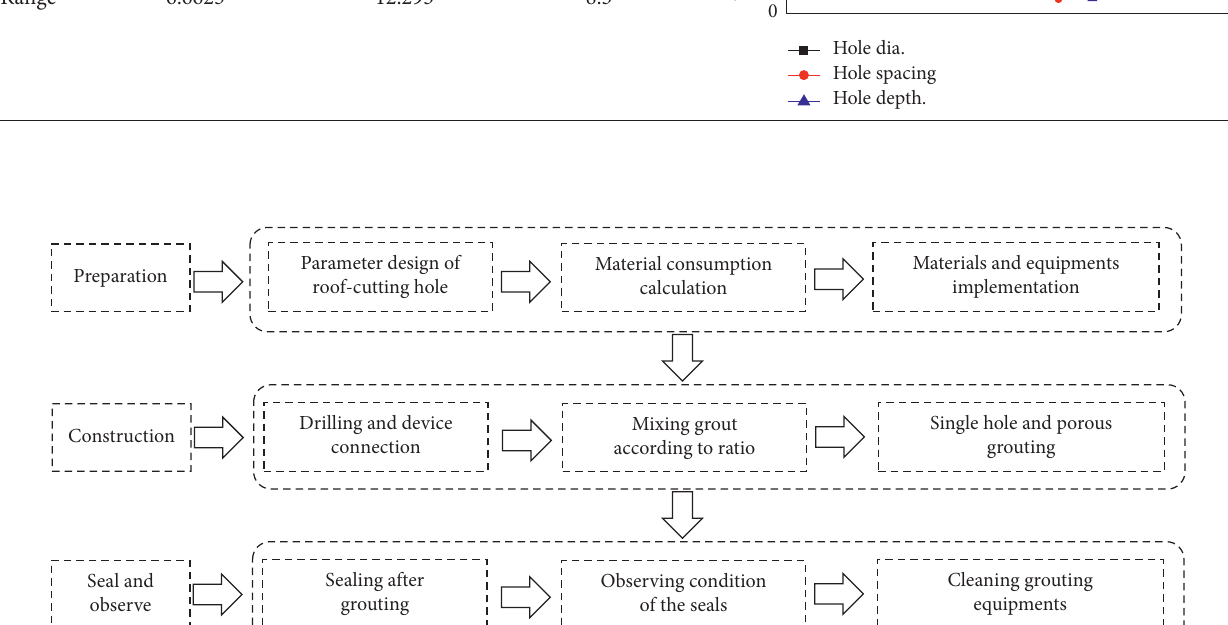
Figure 12: Construction process